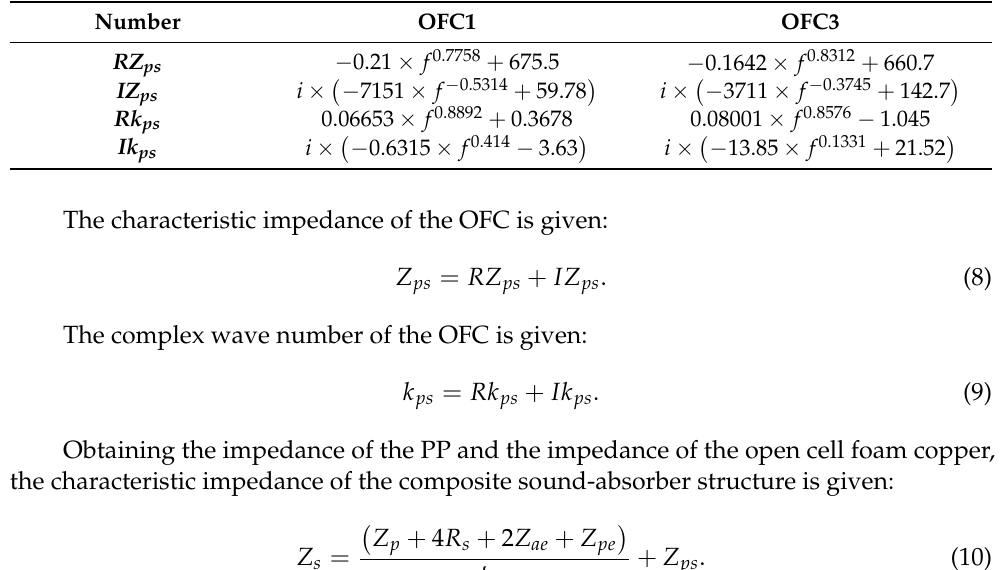
Table 2. The curve fitting results of OFC1 and OFC3.